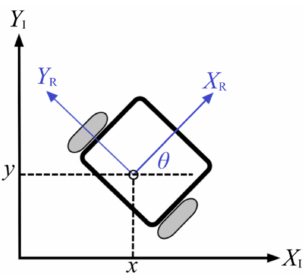
Figure 6. Two coordinate systems of two-wheeled